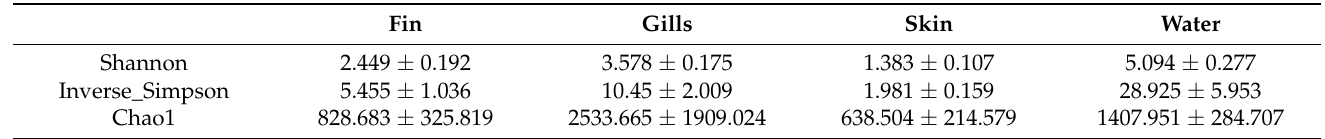
Table 2. Alpha diversity measurements indexes ± standard error mean (SEM) across microbiota location using GLM with Gaussian distribution.